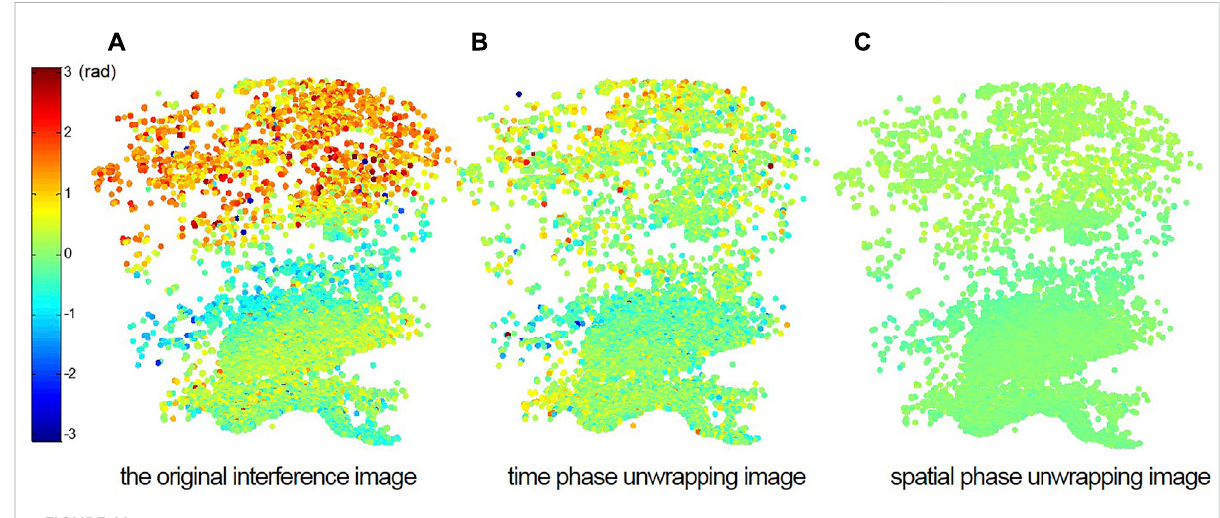
FIGURE 11 Comparison before and after phase unwrapping of an image of HS landslide.